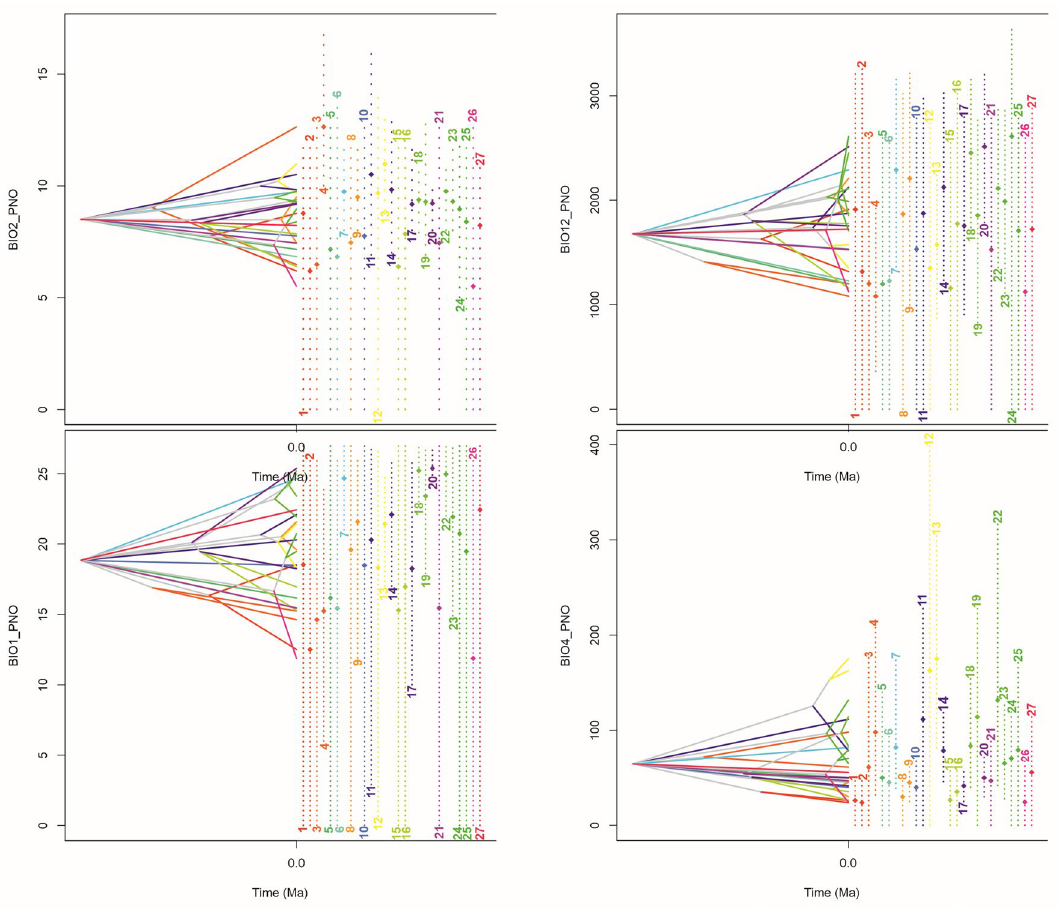
Figure 3. Ecological tolerance evolution for BIO1 (Annual Mean Temperature), BIO2 (Mean Diurnal Range), BIO4 (Temperature Seasonality), BIO12 (Annual Precipitation); 1— E. lancifolius , 2— E. ampliflorus , 3— B. flava , 4— B. dichotoma , 5— B. cattleya , 6— B. ciliata , 7— S. liliastrum , 8— S. pulcherrima , 9— S. rosea , 10— S. luerorum , 11— S. lindleyana , 12— S. xantholeuca , 13— S. macrantha , 14— S. leucoxantha , 15— S. lancea , 16— S. candida, 17— S. crocea , 18— S. fragrans , 19— S. mucronata , 20— S. macrophylla , 21— S. klotzscheana , 22— S. decora , 23— S. violacea , 24— S. chrysostoma , 25— S. warszewiczii , 26— S. ecuadorana , 27— S. powellii. The total time scale = 42.87